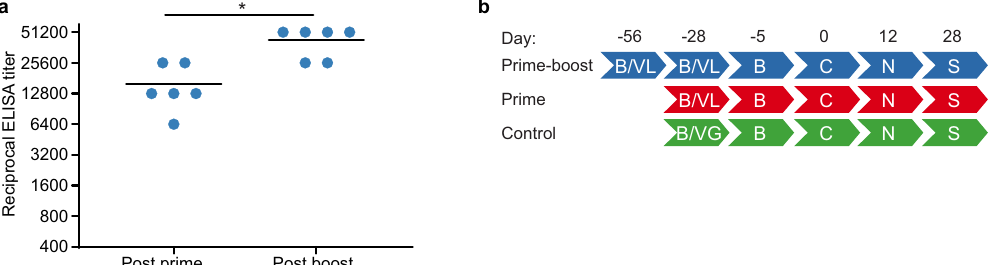
Fig. 3 Vaccination of guinea pigs with ChAdOx1-Lassa-GPC induces a humoral immune response. a Serum samples were collected at 28 days post prime and post boost vaccination in the survival cohort ( n = 6) of the prime-boost experimental group. LASV GP-speci fi c IgG antibody titers in twofold serial-diluted sera were measured by ELISA. Horizontal lines indicate mean titers. Statistical signi fi cance between the post prime and post boost antibody titers was determined via Wilcoxon matched-pairs signed rank test (* p = 0.0312). b Summary of experimental timeline. VL = vaccination with ChAdOx1-Lassa-GPC ( n = 10 per group); VG = vaccination with ChAdOx1-GFP ( n = 10); B = blood collection; C = LASV challenge; N = planned necropsy for comparative virology ( n = 4 per group); S = survival or study endpoint (after adjustment for loss of animals n = 5, n = 6, and n = 4 for the prime-boost, prime, and control experimental groups, Lassa fever. Three groups of animals ( n = 10 per group) received the following immunizations: 3.0 × 10 8 IU of ChAdOx1-Lassa-GPC on D-56 and D-28 (prime-boost), 3.0 × 10 8 IU of ChAdOx1-Lassa- GPC on D-28 (prime), or 1.0 × 10 8 IU of ChAdOx1-GFP on D-28 (control). The immunogenicity of ChAdOx1-Lassa-GPC in guinea pigs was con fi rmed by detection of GP-speci fi c IgG antibodies 28 days post prime (D-28 mean ± SEM ELISA titer = 16000 ± 3200) and 28 days post boost vaccinations (D0 mean ± SEM ELISA titer = 42667 ± 5397) (Fig. 3a). A signi fi cant increase in IgG antibody titer was observed after administration of a second dose of ChAdOx1-Lassa-GPC ( p = 0.0312, Wilcoxon matched-pairs signed rank test).